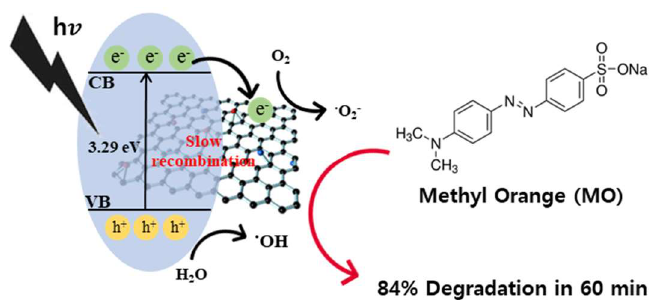
Figure 7. Schematic of MO dye photodegradation by using SnO 2 aerogel/reduced graphene oxide nanocomposites under ultraviolet light. Table 3 Comparison of photocatalytic performance of SnO 2 aerogel/rGO nanocomposite photocatalyst in this work with previously reported composite photocatalysts